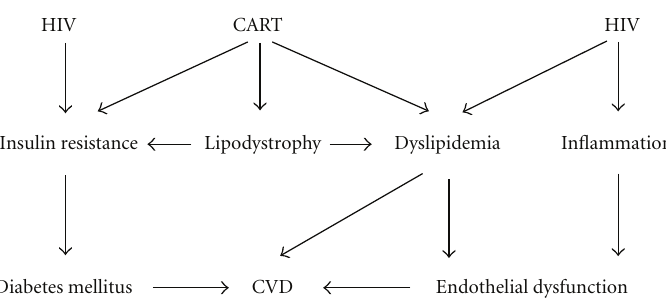
Figure 3: Pathogenesis of CVD in HIV-infected patients. HIV infection itself has been associated with subclinical atherosclerosis due to a low-grade inflammatory response leading to endothelial dysfunction. CART may promote atherosclerosis through its e ff ects on body fat distribution, lipid metabolism and insulin sensitivity. Presumably, both HIV infection and CART promote atherosclerosis, either directly or indirectly via metabolic risk